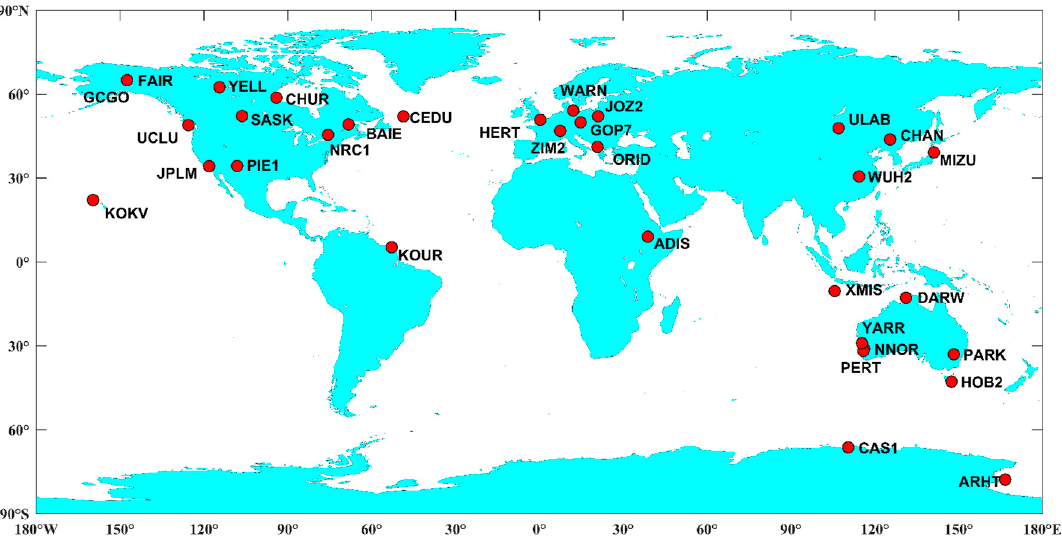
Figure 4. Distribution of the collected 33 IGS stations.